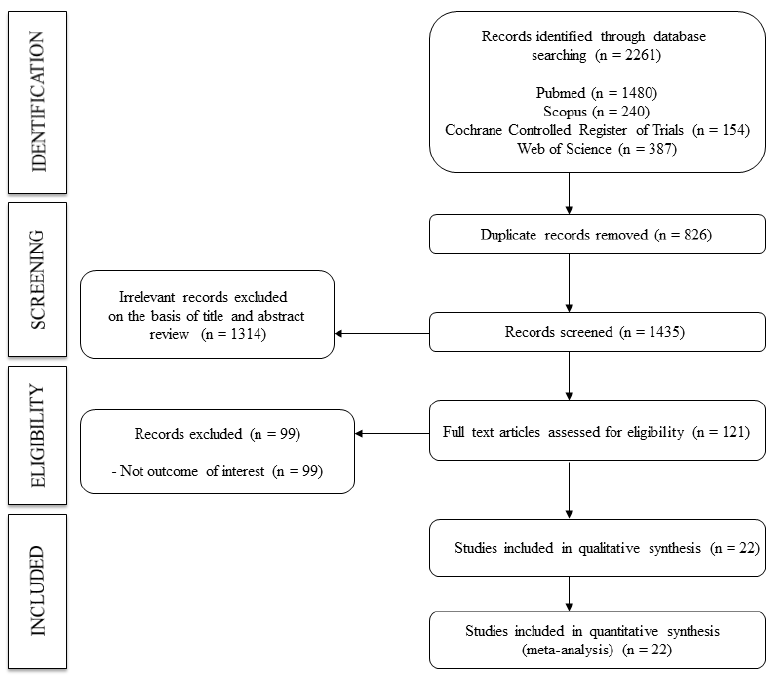
Figure 1. Figure 1. Flowchart.